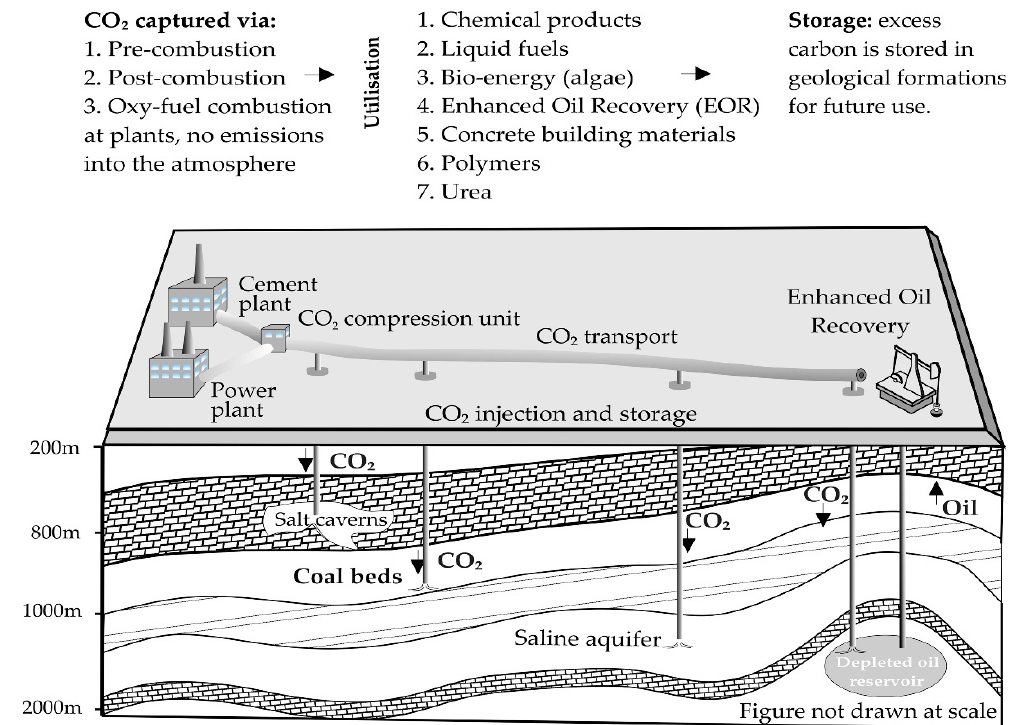
Figure 1. Depiction of CCUS technology.